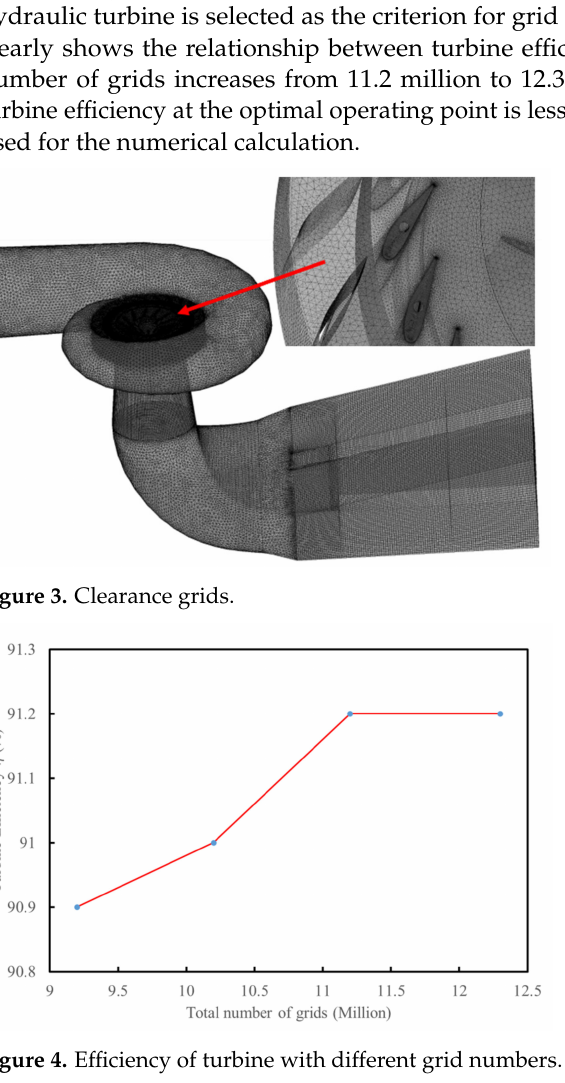
Figure 4. Efficiency of turbine with different grid